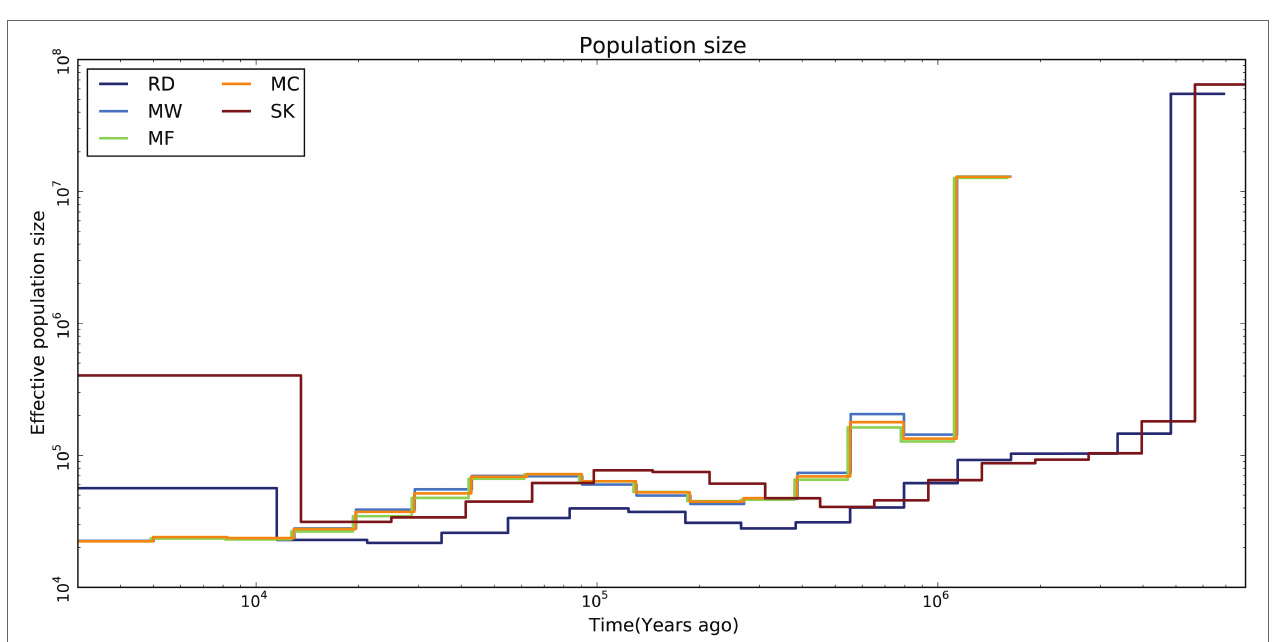
FIGURE 3 | Demographic history of Père David’s deer populations (MC, MF, and MW), Red deer (RD) and Sika deer (SK). Effective population size by time was estimated using MSMC2.